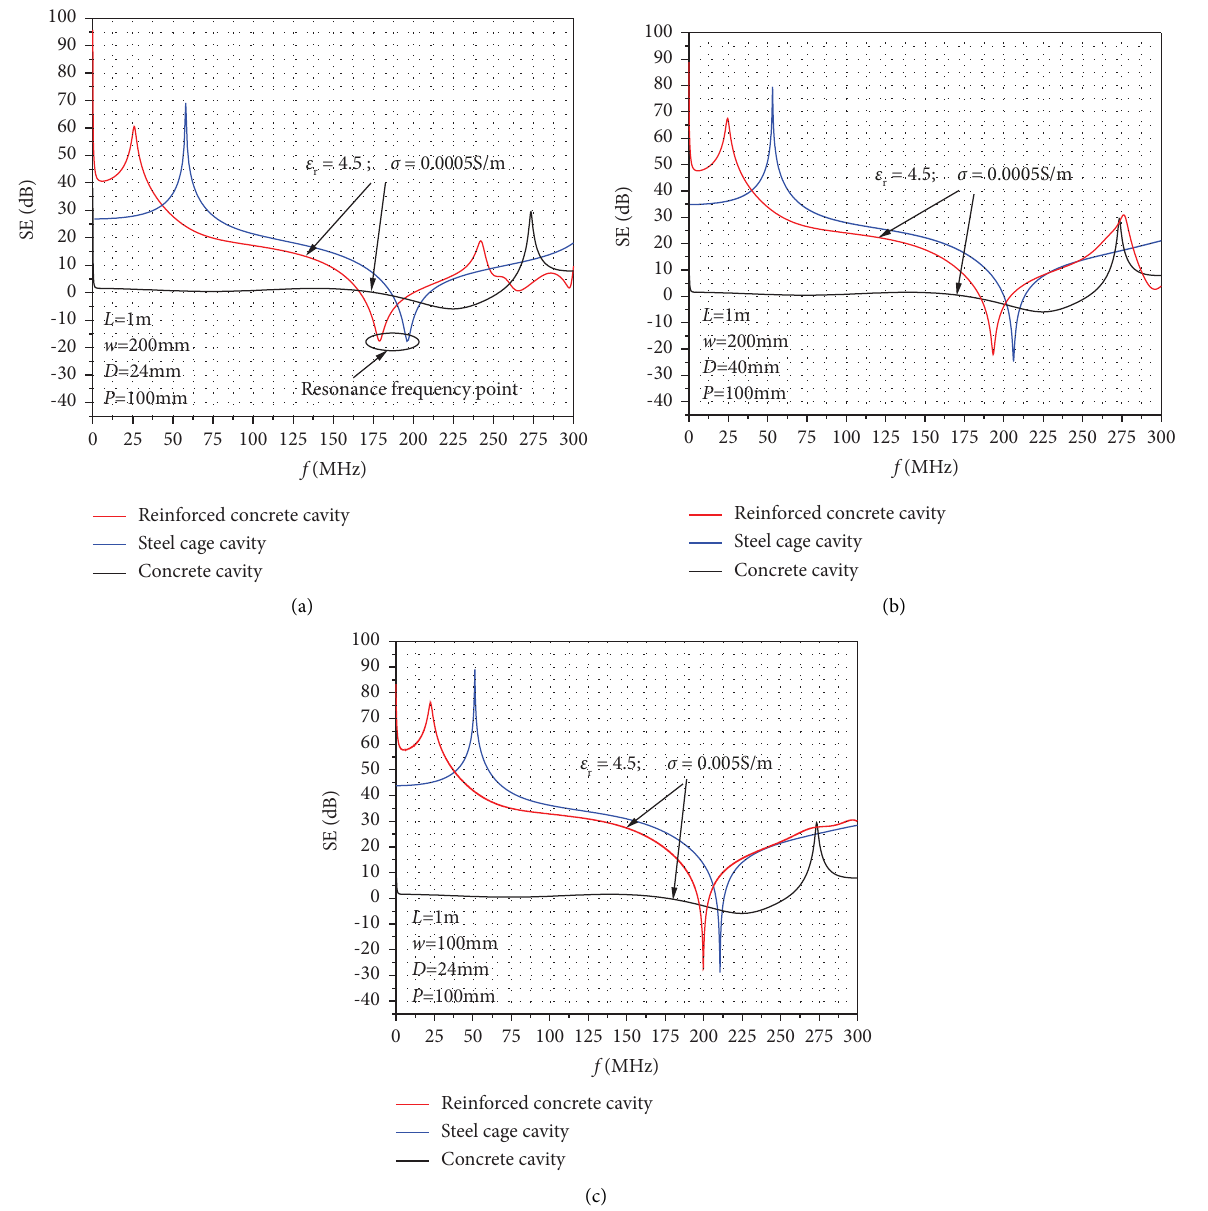
Figure 3: Comparison of shielding efectiveness of three shielding structures under diferent steel structure parameters: (a) L � 1m, w � 200mm, D � 24mm; (b) L � 1 m, w � 200mm, D � 40mm; (c) L � 1m, w � 100mm, D �